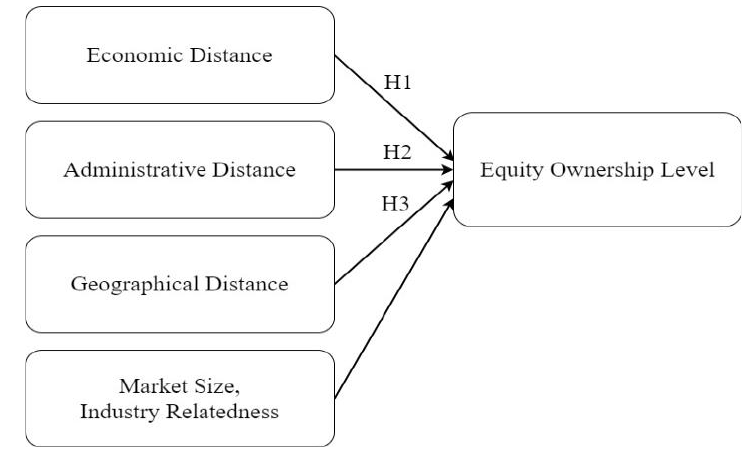
Figure 1: Conceptual Model of the Study; Source :